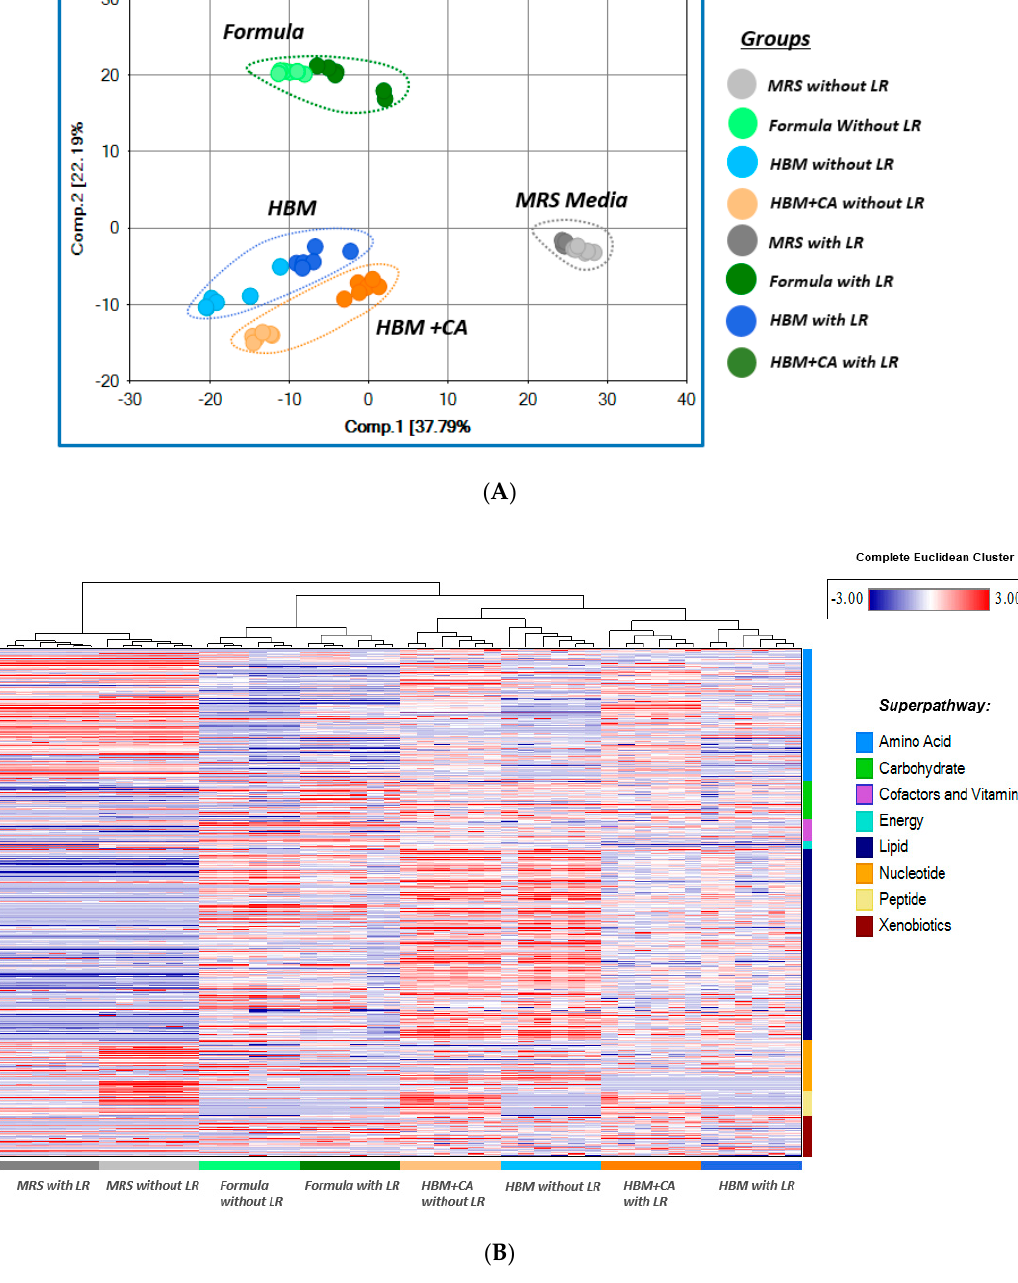
Figure 2. (A) Principal component analysis (PCA) showed major segregation among the different media. ( B ) Hierarchical clustering analysis showed major segregation among the groups, based on both media and LR growth status. Each column represents a separate culturing sample (6 samples per group). Each horizontal line represents an identified metabolite (679 metabolites identified from mass spectrometry). Red indicates up-regulated metabolites, while blue indicates down-regulated metabolites.